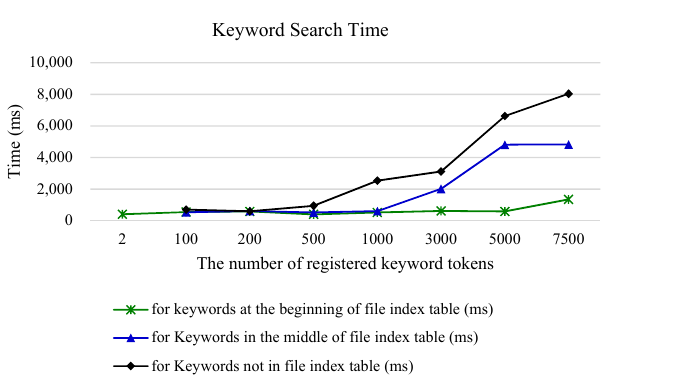
Figure 6. Contract encryption and delivery time.